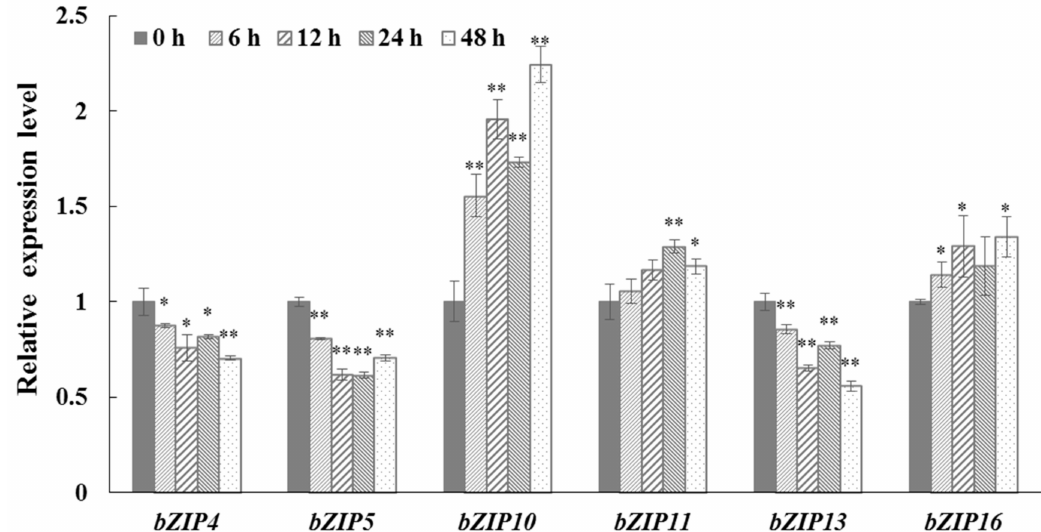
Figure 9. Expression profiles of six CrebZIP genes in C. reinhardtii under salt stress. Expression of CrebZIP genes was determined by qRT-PCR using total RNA from microalgae cells sampled at different time points of salt treatment. The α -tubulin gene was used as the internal reference gene. Each value is the mean ± SD of six biological replicates. Asterisks indicate statistical significance (* 0.01 < p < 0.05, ** p < 0.01) between control and salt-treated cells according to the Tukey’s